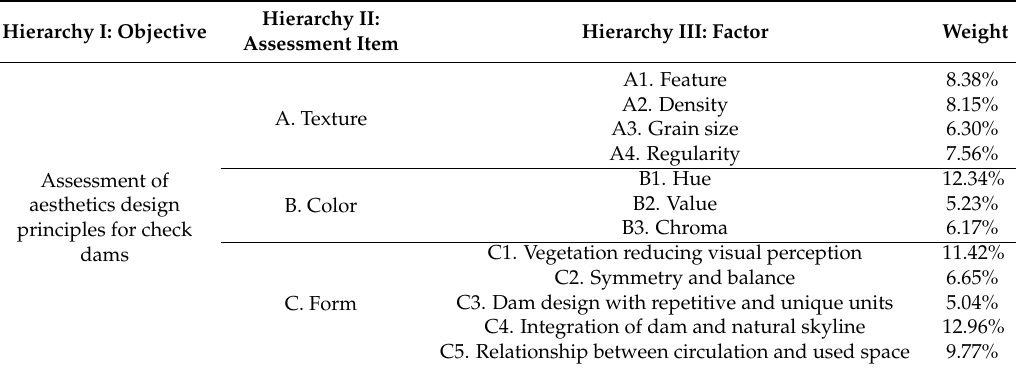
Table 5. Weights of assessment factors using the Analytic Hierarchy Process